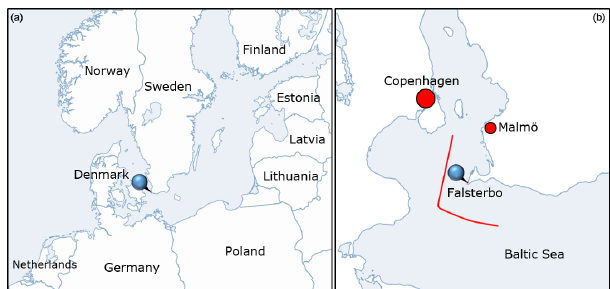
Figure 1. Map of the Baltic Sea region (a) and the nearby region around the field site (b) . The measurement site Falsterbo is marked with blue pin, and the nearby large cities Copenhagen and Malmö are marked with red circles. The red line shows a typical route of a ship following the main shipping lane around the Falsterbo penin- sula, based on AIS position